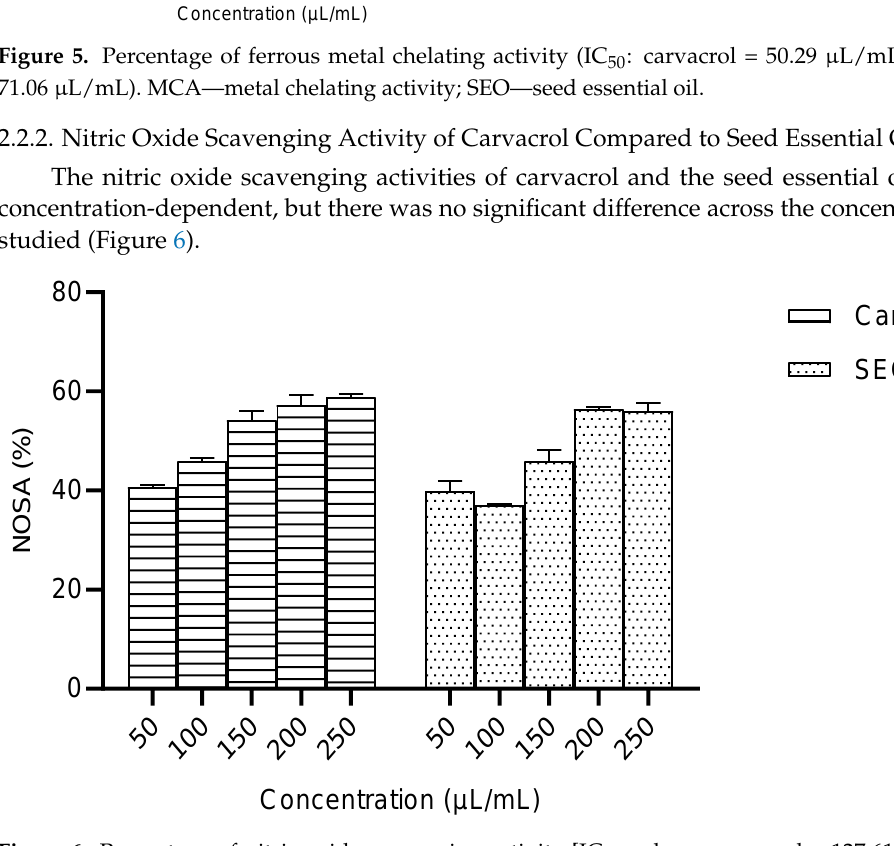
Figure 6. Percentage of nitric oxide scavenging activity [IC 50 values: carvacrol = 127.61 µL/mL; SEO = 165.18 µL/mL]; SEO—seed essential oil; NOSA—nitric oxide scavenging activity.